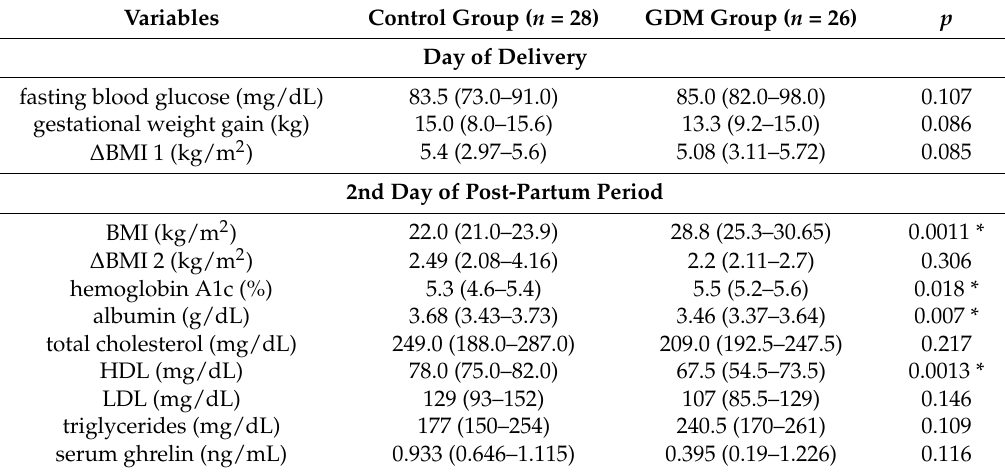
Table 1. Comparison of characteristics of the